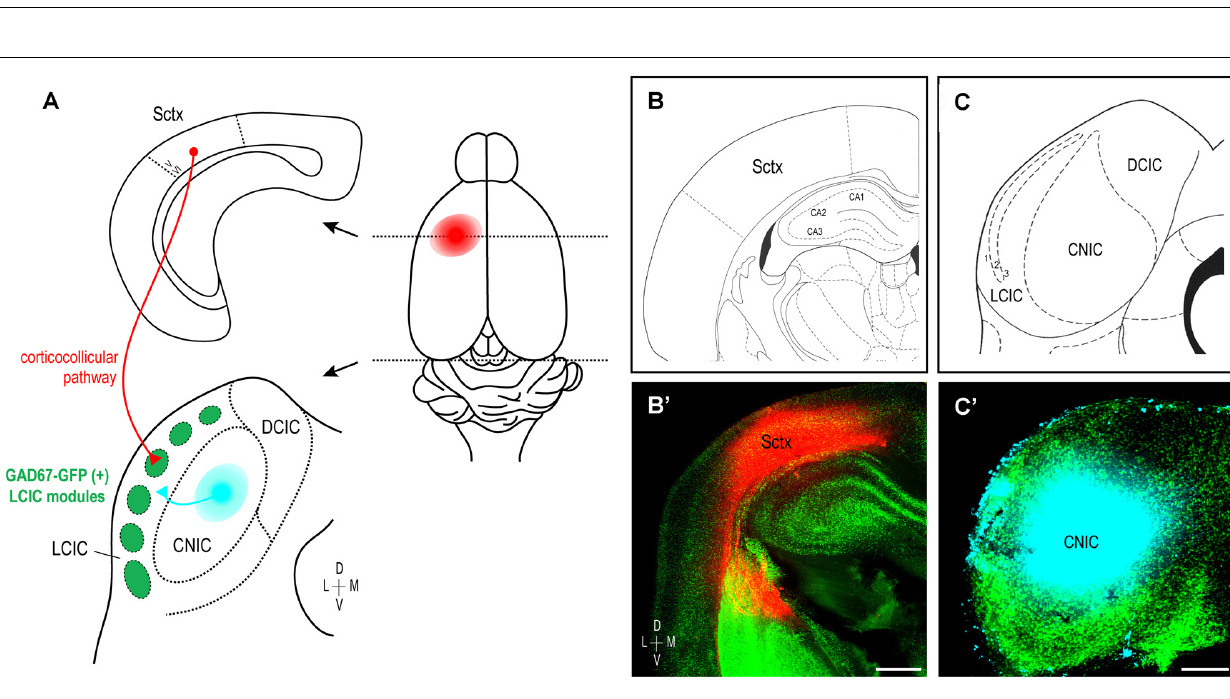
FIGURE 7 | Experimental design schematic and verification of tracer placements. Simultaneous labeling of somatosensory and auditory LCIC afferents in early postnatal GAD67-GFP mice (A) . Biocytin placements made in the left somatosensory cortex label descending corticocollicular projections arising from layers 5/6 (red). Dextran positioned in the left CNIC labels auditory inputs (cyan) to the neighboring LCIC. Photomicrographs of coronal sections in a P4 mouse matched with corresponding atlas plates confirm accurate dye placements (B,B’,C,C’) . Scale bar in (B’) = 500 µ m, in (C’) = 200 µ